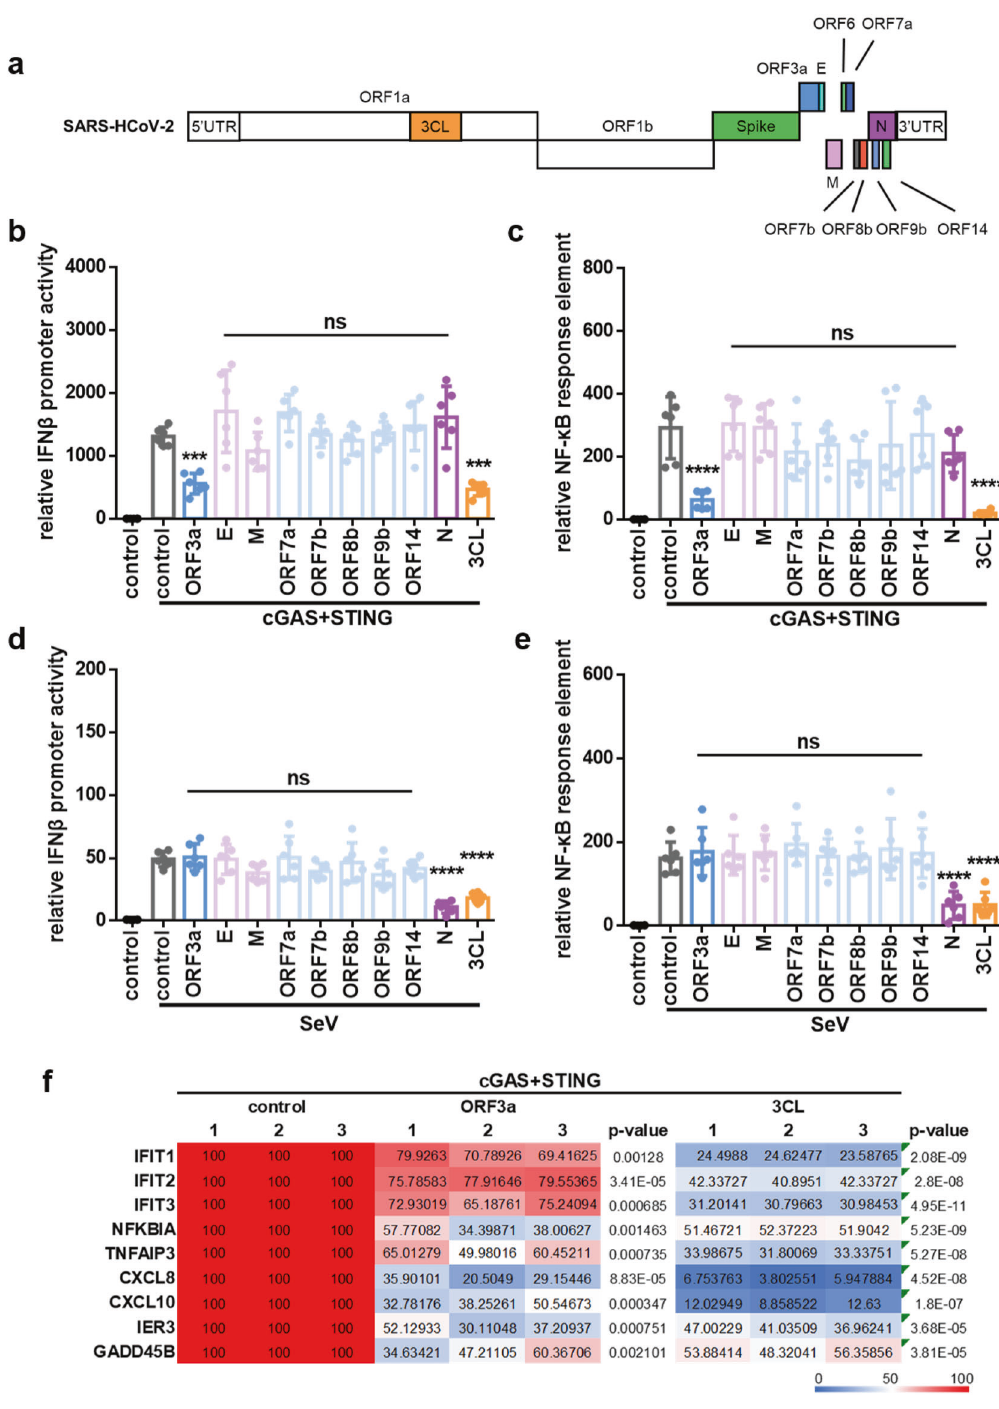
Fig. 1 Identi fi cation of SARS-CoV-2 proteins involved in innate immune suppression. a Schematic diagram of the genomic organization and encoded proteins of SARS-2019 Wuhan-Hu-1 strain (MN908947.3). b , c cGAS-STING-stimulated IFN β promoter ( b ) and NF- κ B response element ( c ) activation is inhibited by ORF3a and 3CL. HEK293T cells were co-transfected with IFN β -Luc ( b ), NF- κ B-Luc ( c ), and the cGAS and STING expression vectors in the presence or absence of vectors expressing various SARS-CoV-2 proteins as indicated. d , e SeV-induced IFN β promoter ( d ) and NF- κ B response element ( e ) activation is inhibited by protein N and 3CL. HEK293T cells were co-transfected with IFN β -Luc ( d ) or NF- κ B-Luc ( e ) in the presence or absence of vectors expressing various SARS-CoV-2 proteins as indicated. SeV was added to the culture medium 12h after transfection. pRL-TK Renilla was used as an internal control ( b – e ). Transactivation of the luciferase reporter was determined 24 h after transfection ( b , c ) or 12h after SeV infection ( d , e ) ( n = 6 independent biological experiments). Means and standard deviations are presented. Statistical signi fi cance was determined by two-sided unpaired t test, *** p <0.001; **** p < 0.0001; NS, no signi fi cance ( b – e ). f Inhibition of cGAS-STING-stimulated human genes by ORF3a and 3CL of SARS-CoV-2. HEK293T cells were co-transfected with the cGAS-STING expression vectors in the presence or absence of the ORF3a or 3CL expression vectors as indicated. Human genes activated by cGAS-STING alone served as a positive control and were set to 100%. Total RNA was prepared from HEK293T cells 24 h after transfection and analyzed for the transcriptional level of the indicated genes by RT-qPCR ( n = 3 independent biological experiments). Statistical signi fi cance was determined by two-sided unpaired t test Signal Transduction and Targeted Therapy (2021)